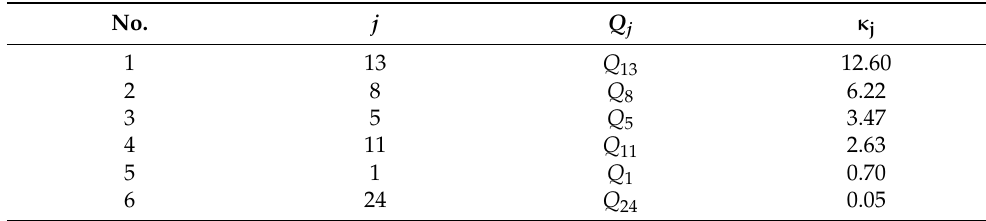
Table 15. A Ranking List of the Dominant Nodal Reactive Powers when the Index κ is Adopted as Criterion for Case